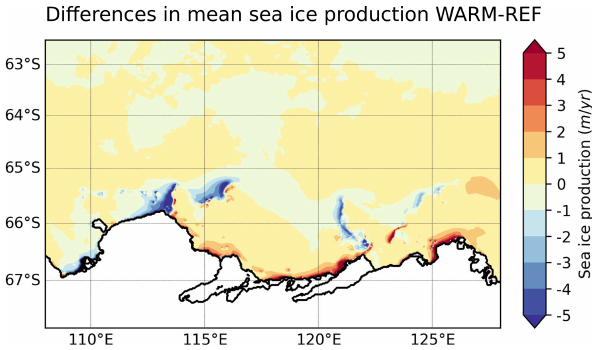
Figure 6. Differences in mean sea ice production between WARM and REF, averaged over the 20 years of simulation. Positive values mean that WARM has more sea ice production than